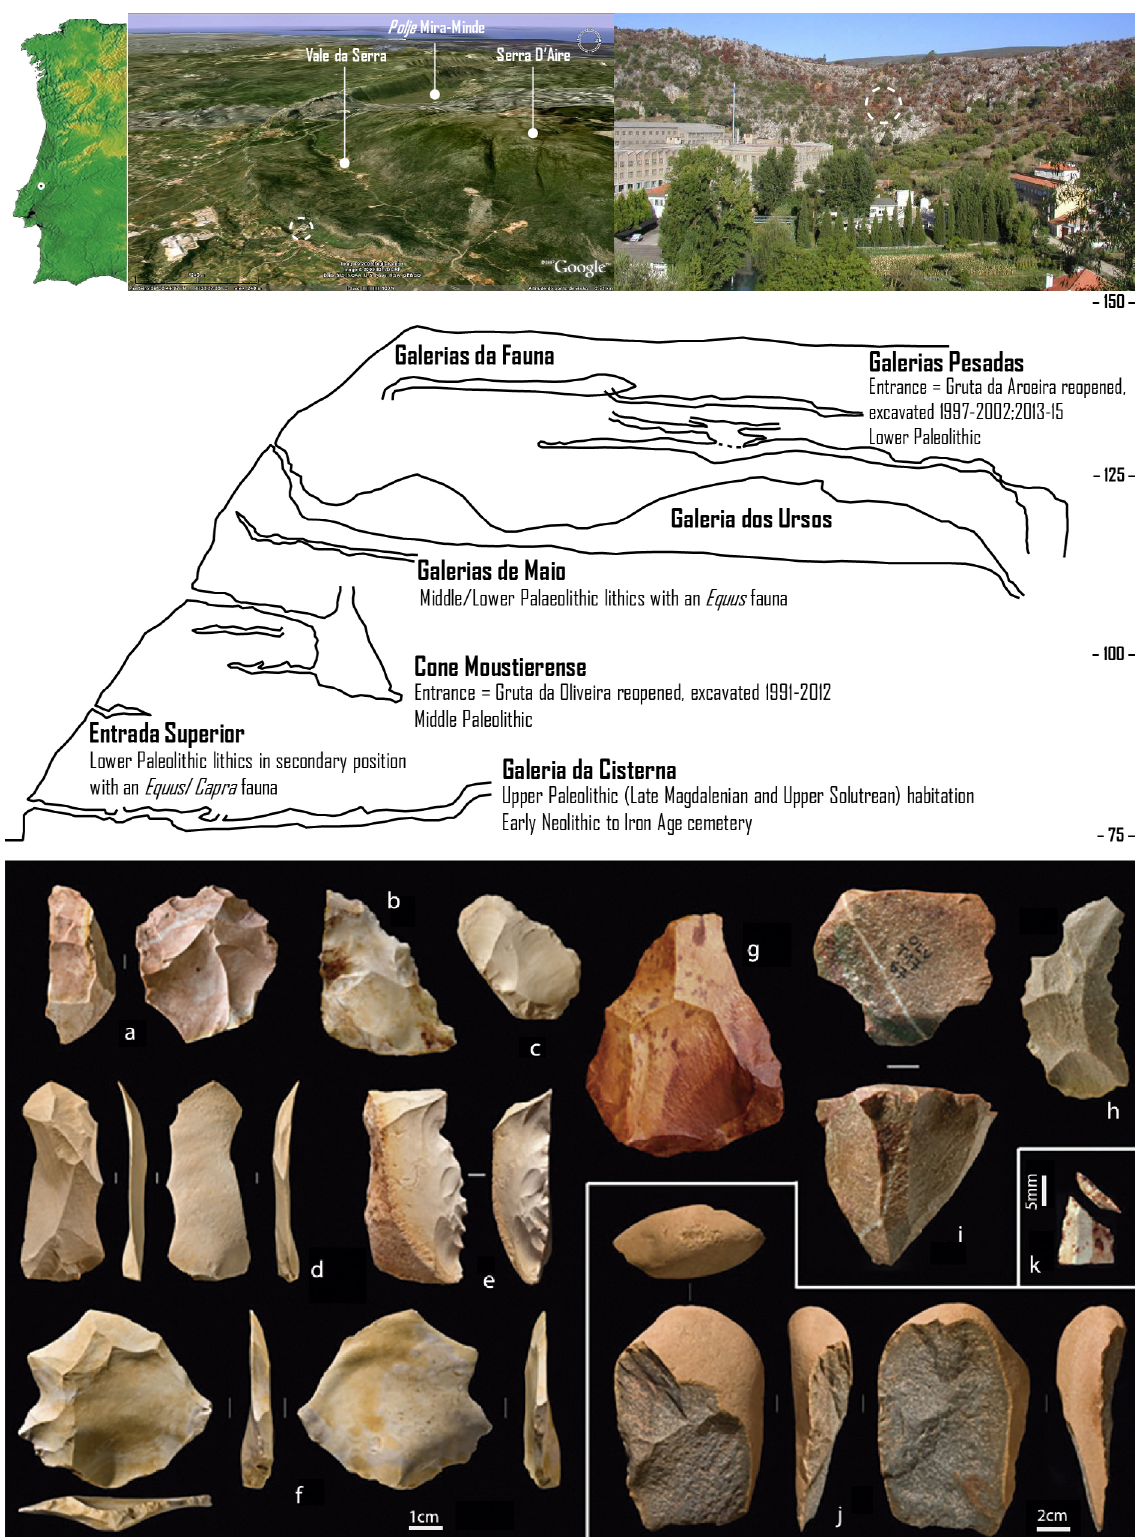
Figure 1. The location of Gruta da Oliveira (top), schematic cross-section of the Almonda escarpment showing the position of the main archeological sites (center), and a selection of stone tools from Gruta da Oliveira (base): a. Levallois core, layer 20; b. Denticulate sidescraper, layer 26; c. Sidescraper, layer 26; d. Levallois blade, layer 20; e. Denticulate, layer 14; f. Levallois flake, layer 19; g. Levallois core, layer 13; h. Denticulate, layer 26; i. Pyramidal core, layer 10; j. hachereau , layer 20; k. Truncated bladelet, layer 14; a.-f. and k., flint; g. -j., quartzite. (Photos b. to k. by João Zilhão; Photos a., j. and k. by José Paulo Ruas (after Hoffmann et al. 2013; Zilhão et al.